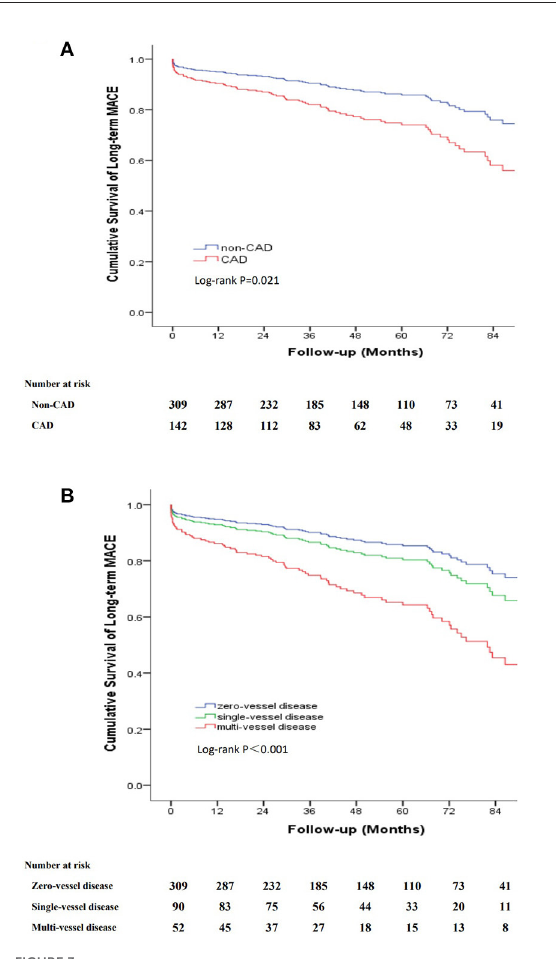
FIGURE3 Kaplan-Meier curve for cumulative survival rates of long-term MACE. (A) Classified by TBAD patients with and without CAD. (B) Classified by the number of identified stenosed coronary